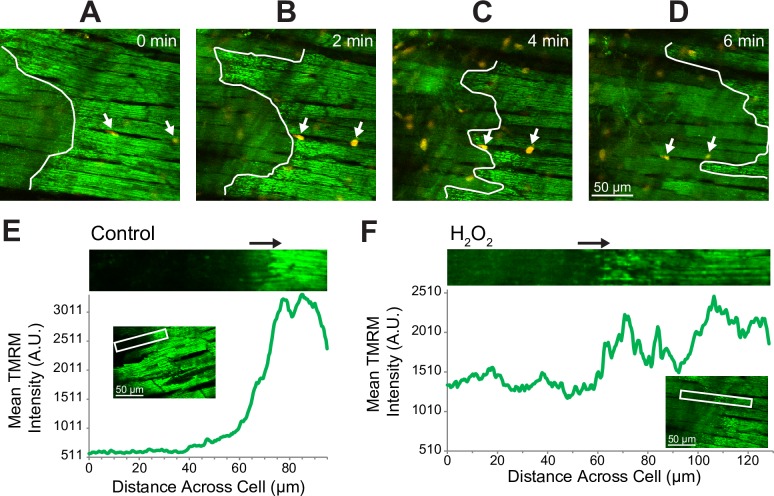
Wave-like propagation of MPT caused by H2O2.The time is shown according to the onset of observation starting 6 min after the end of H2O2 application (200 μM). A to D, consecutive snapshots taken every 2 minutes. Green, fluorescence of TMRM (FTMRM); orange, fluorescence of YO-PRO1 (FYO-PRO1). The nature of objects brightly stained with YO-PRO1 is unknown, but they may represent dead fibroblasts or other cell types which are usually abundant in the most superficial layers and are visible immediately after YO-PRO1 delivery to the heart. White arrows point to two such bright objects, which were used as fiducial points to track myocytes amid slight changes in the field of view and the focal plane. Note that unlike the naturally occurring MPT/SP events, H2O2-induced MPT propagated as a wide front (white line), easily crossing cell boundaries, and was not associated with immediate cellular YO-PRO1 uptake. E and F, Different structure of the propagating front of FTMRM loss during naturally occurring MPT (E; same cell as #13 in S4 Fig as well as in S5 Movie) and H2O2-induced MPT (F). In each Panel, FTMRM was computed as the function of the distance along the long axis of the rectangular region of interest (ROI) approximating the selected cell (white rectangle). The magnified image of the ROI is shown at the top of each Panel. For each x-position along the cell, FTMRM was averaged over all pixels in the respective column (across the width) of the rectangle. This yielded an instantaneous profile of the propagating wave (green curve). The minimal value on the y-axis of mean FTMRM represents the minimal value in the field of view (extracellular level, or background). Note that during naturally occurring MPT (E) the level of FTMRM in the wake of the MPT front is very close to the background level indicating complete loss of the TMRM in that part of the cell. In contrast, during H2O2-induced MPT (F) the level of FTMRM in the wake of the MPT front remains at about 50% of the dynamic range.